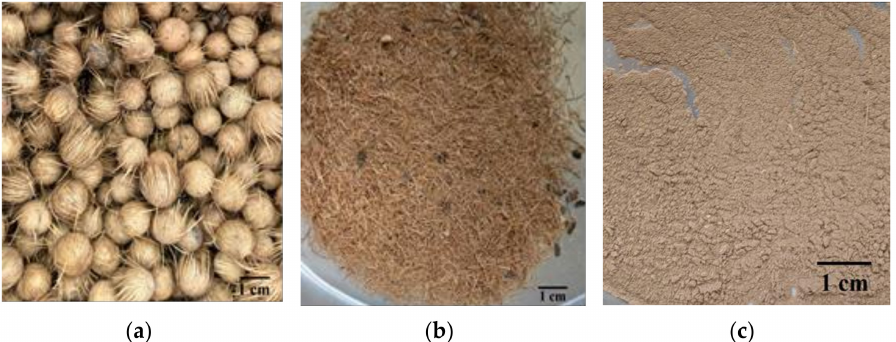
Figure 1. Aça í waste: ( a ) Lump; ( b ) Natural aça í fibers [23]; ( c ) Ground aça í